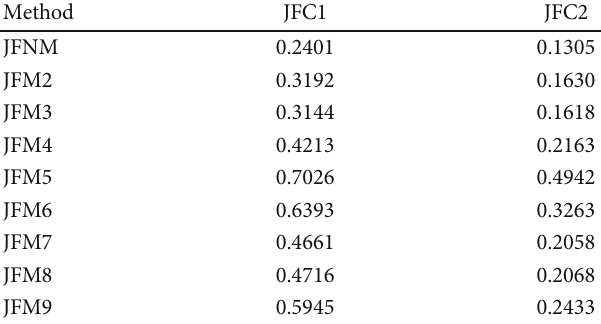
Table 20: Values of FJC1 and FJC2 for Methods 1-11 to solve Test Problem 5, by the algorithms of the third category for n = 250